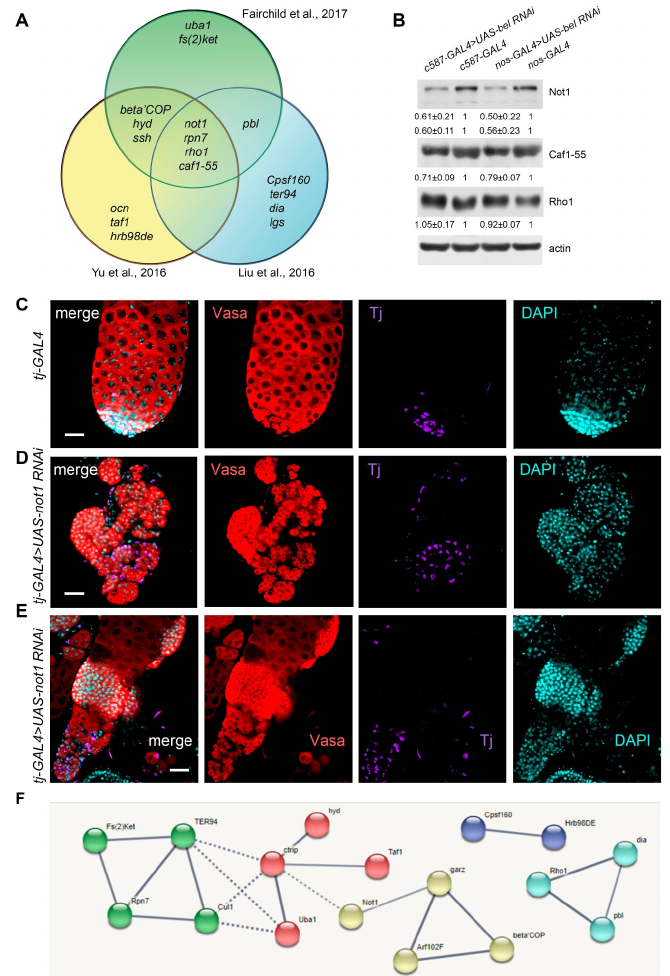
Figure 5. Comparative analysis of candidate targets of Belle CLIP-seq with the results of published screens. ( A ) A Venn diagram shows the overlap of genes, RNAi knockdowns of which provide the morphological defects similar to RNAi belKD in the testes according to data of three independent screens [53–55], and which were determined in our CLIP-seq analysis as putative mRNA targets of Belle. Knockdowns of four genes, not1, rpn7, rho1, and caf1-55 , provide the same morphological defects in the testes, according to data from all three independent screens. ( B ) Western blot analysis of testis lysates of c587-GAL4 > UAS-bel RNAi males, nos-GAL4 > UAS-bel RNAi males, and the corresponding driver lines as controls. Anti-actin antibodies were used as a loading control. The values (obtained by using ImageJ software) were normalized to the loading control level (actin) and then to the values obtained for the control lysates. Mean values and standard errors are presented for at least three independent experiments. We revealed a decrease in the level of Not1 and Caf1-55 proteins in the testes with belKDs ; however, we did not detect significant changes in the level of Rho1. ( C – E ) Immunostaining of fixed testis preparations of males with RNAi knockdown of not1 using soma-specific driver tj-GAL4 . Testes of newly eclosed males were stained with anti-Vasa (red) and anti-Tj (violet) antibodies; chromatin was stained by DAPI (4 (cid:48) ,6-diamidino-2-phenylindole, blue). Scale bars are 30 µ m. ( C ) Control testes contained a wild-type array of cells at all stages of spermatogenesis. ( D ) Most of not1KD testes are filled by tumor-like clusters of small germ cells and somatic cyst cells placed separately. ( E ) In the remaining not1KD testes clusters of small germ cells were found along with di ff erentiating germ cells. ( F ) Interaction cluster analysis of genes from the full list of Belle CLIP-targets shared with the results of the screen studies (Table S3) was performed by STRING database tools. Only 17 of 22 genes form five interacting clusters with high confidence settings (interaction score 0.7). The thickness of the line between genes (color balls) reflects the relative probability of interaction. See Table S4 for a detailed